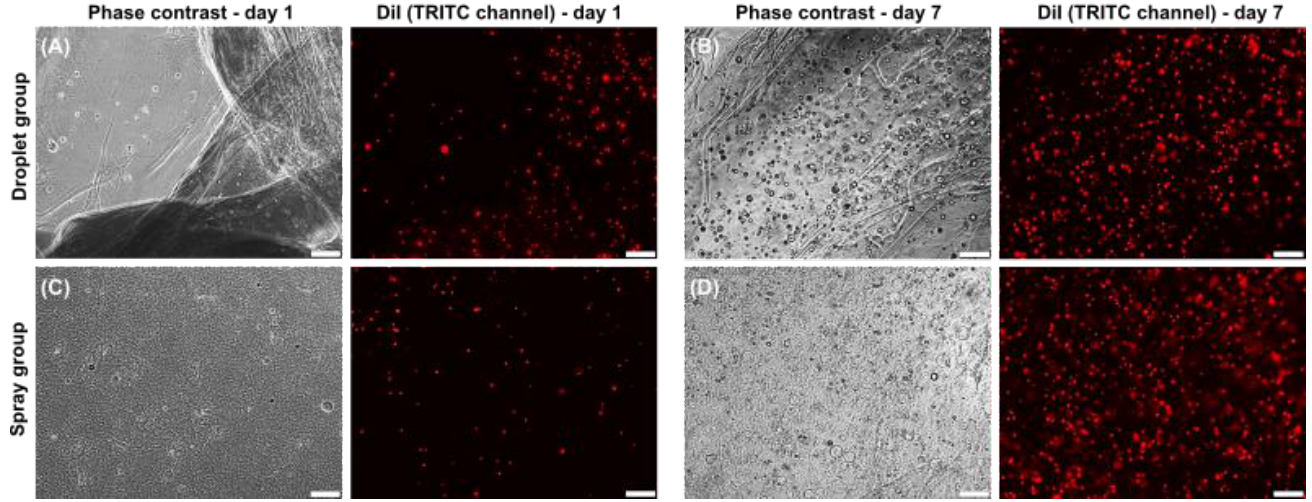
Figure 3. Keratinocytes after droplet and spray application. ( A – D ) Representative images of dripped ( A ) and sprayed ( B ) keratinocytes at time points 1 and 7 d, phase contrast and CellTracker™-CM-Di-I-labelled keratinocytes (red). Scale bar 200 µm.